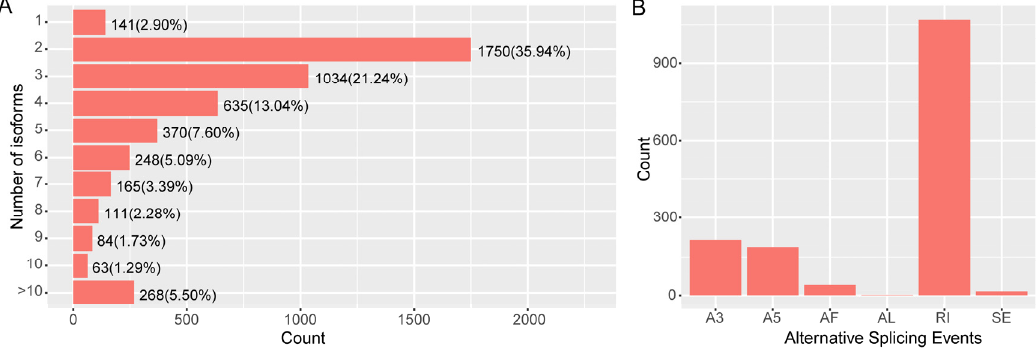
Figure 5. AS events in M. pilosus. ( A ) The statistics of isoform number. ( B ) The statistics of AS